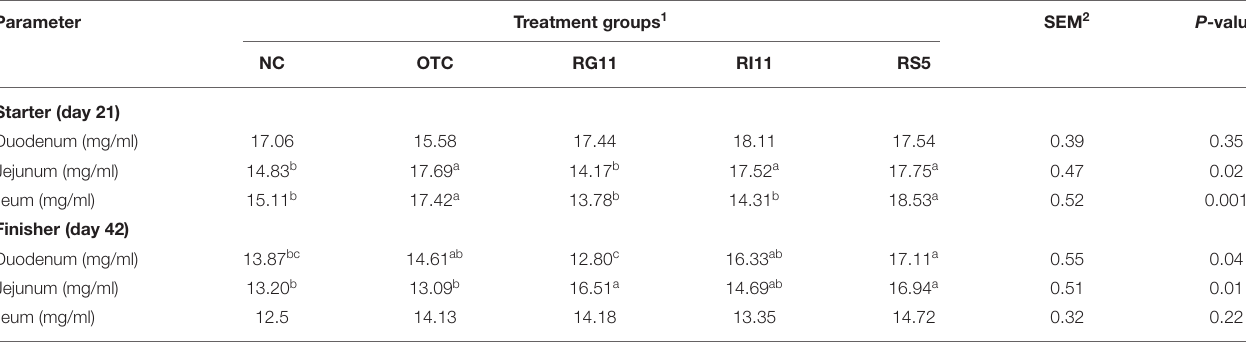
TABLE 8 | The SOD concentration of chickens when fed different postbiotics. Parameter Treatment groups